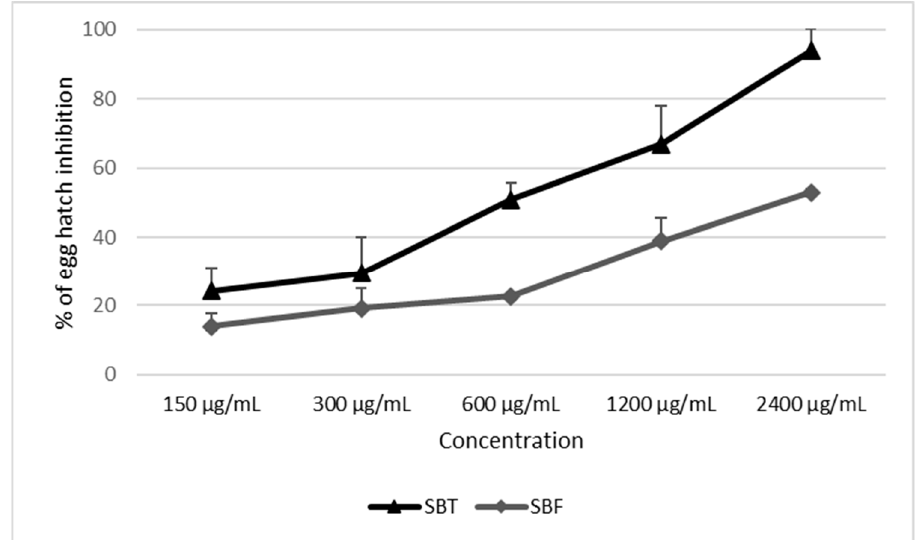
Figure 4. Concentration–response curves of GIN egg-hatch inhibition percentages caused by the sea